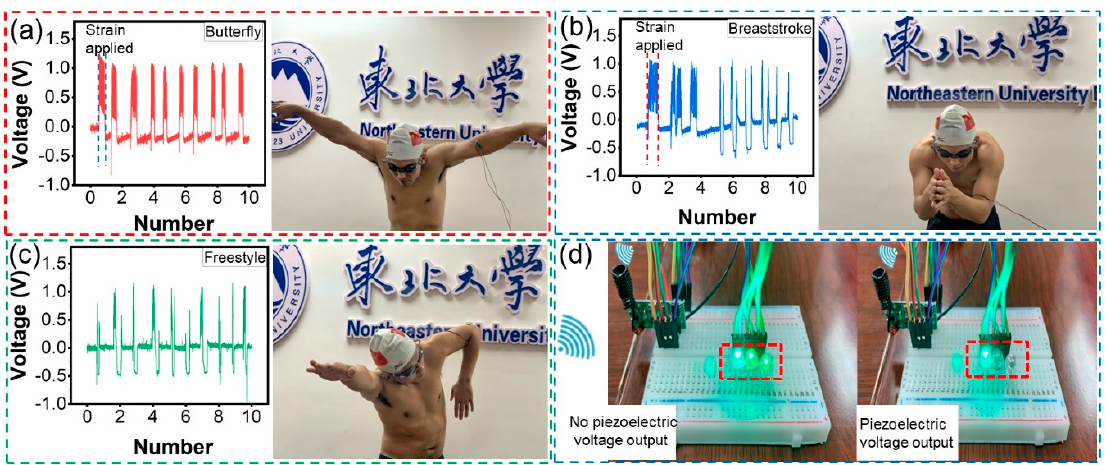
Figure 5. Experimental design of integrated wireless transmitter and receiver for biosensor. ( a ) Output piezoelectric voltage of butterfly stroke. ( b ) Output piezoelectric voltage of breaststroke. ( c ) Output piezoelectric voltage of freestyle stroke. ( d ) Wireless transmission analysis station.